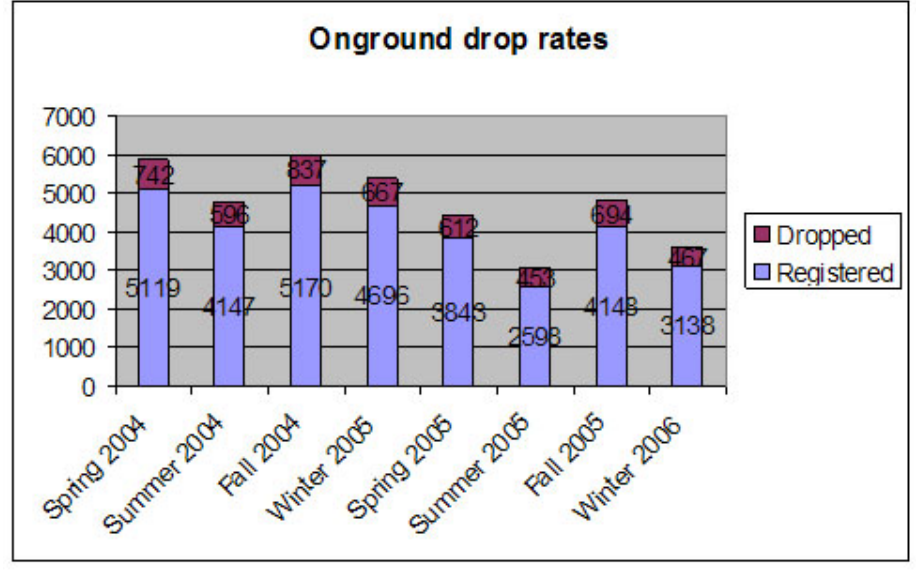
Figure 2 . Drop pattern in onground courses by quarter